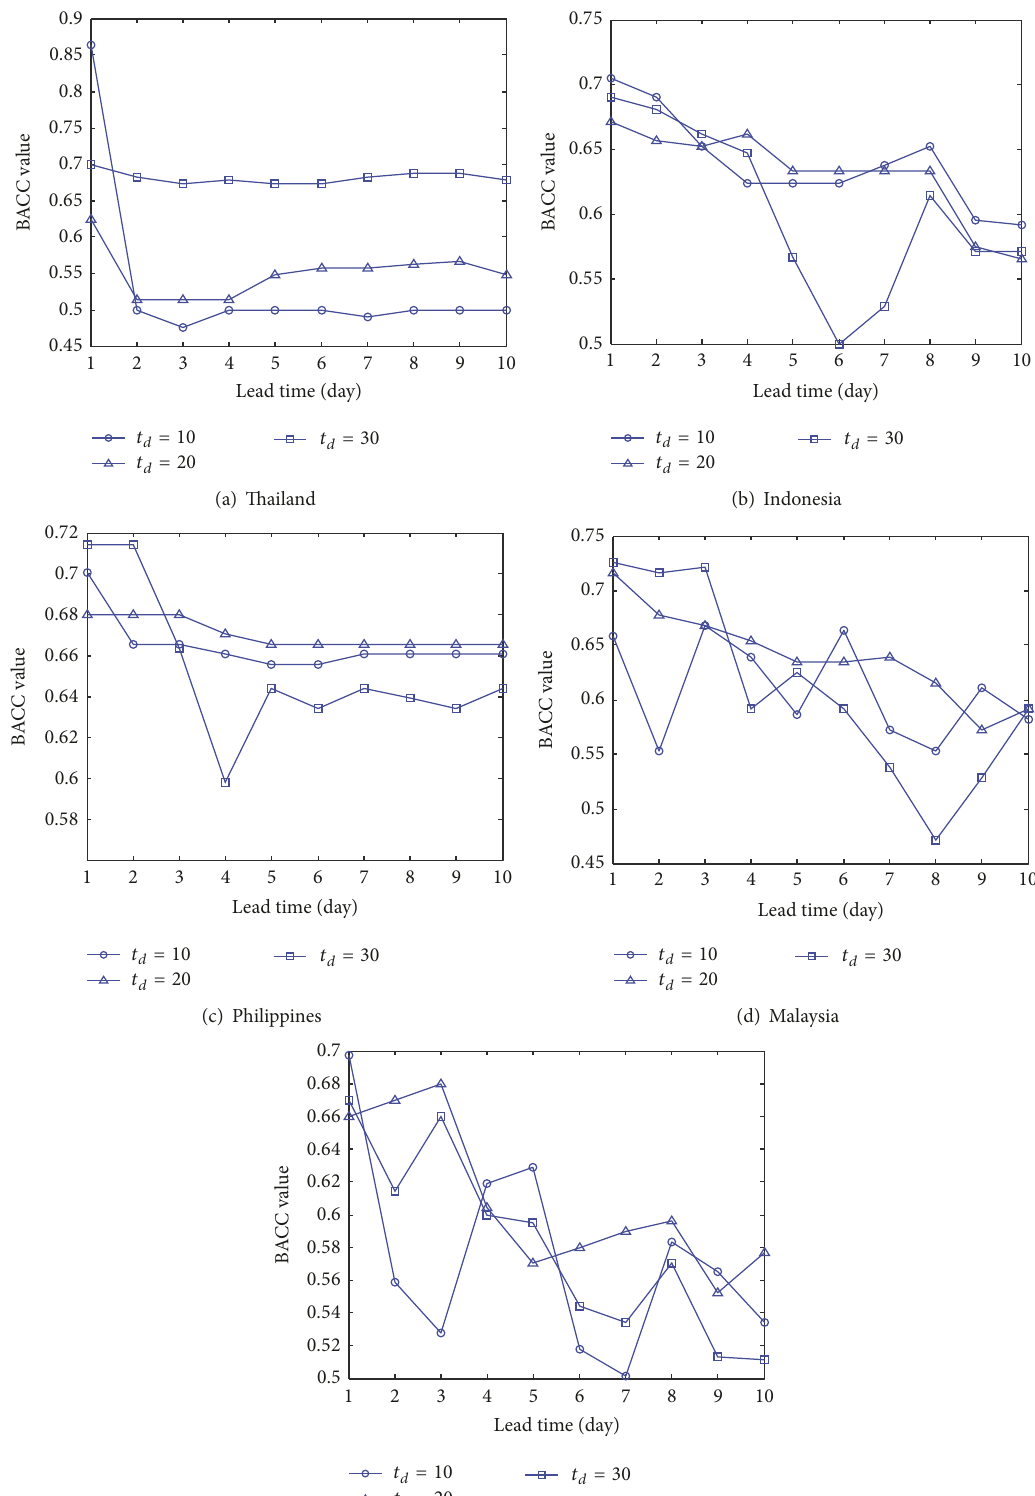
Figure 8: Sensitivity analysis on lead times Δ𝑡 𝑙 and data window size Δ𝑡 𝑑